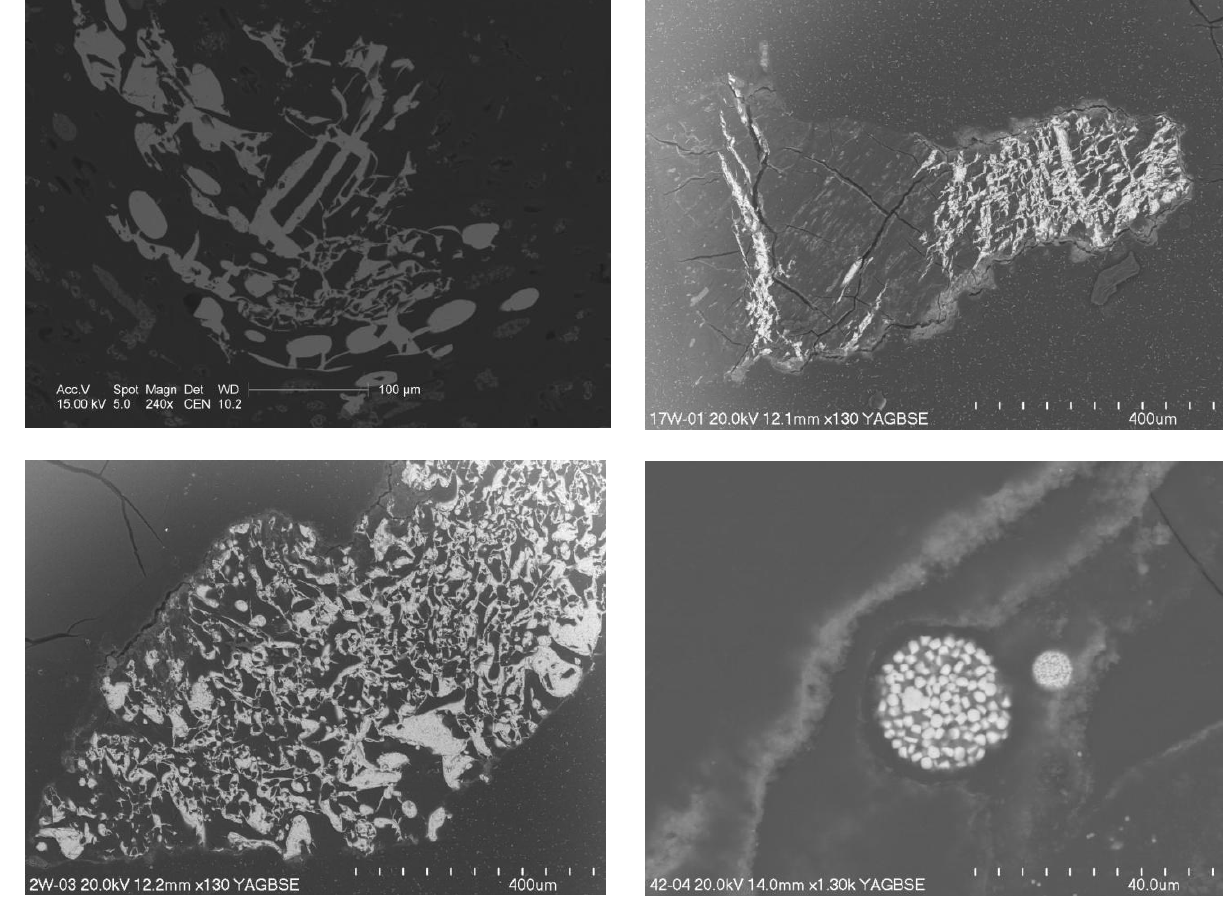
Fig. 5. SEM image o f pyrite forms in ash from flotation concentrate of bituminous coal combustion in individual household